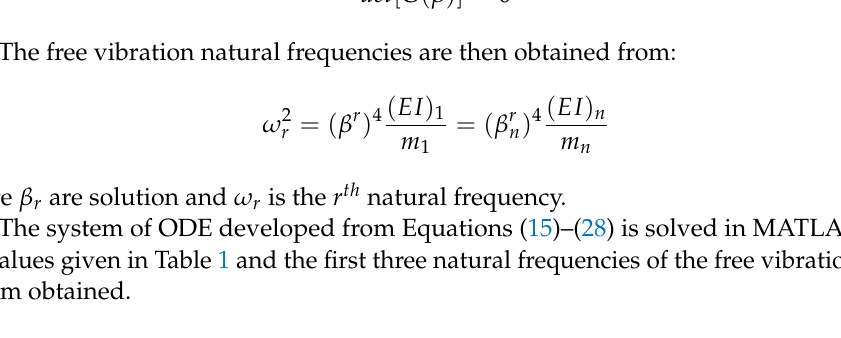
Table 1. Values used to solve ODEs in MATLAB.